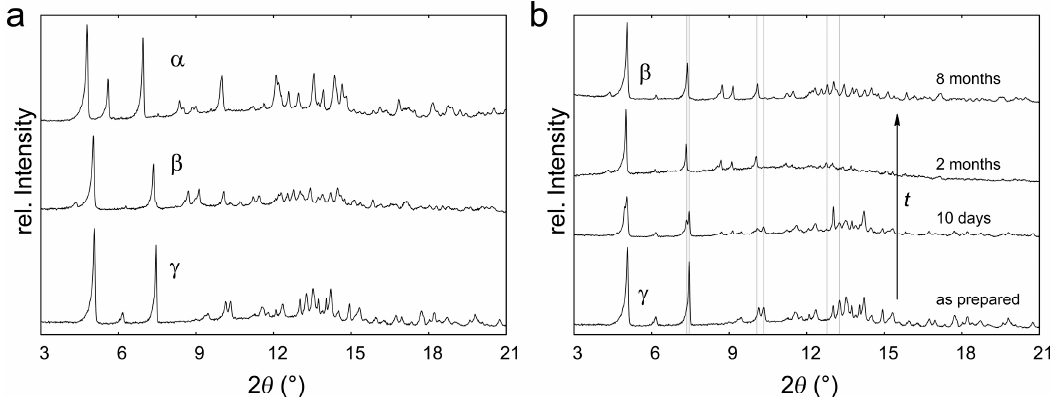
Figure 2. Diffraction patterns of the different polymorphs of Eu(CN 3 H 4 ) 2 ( a ) and the transformation from the γ -phase to the β -phase over time ( b ).